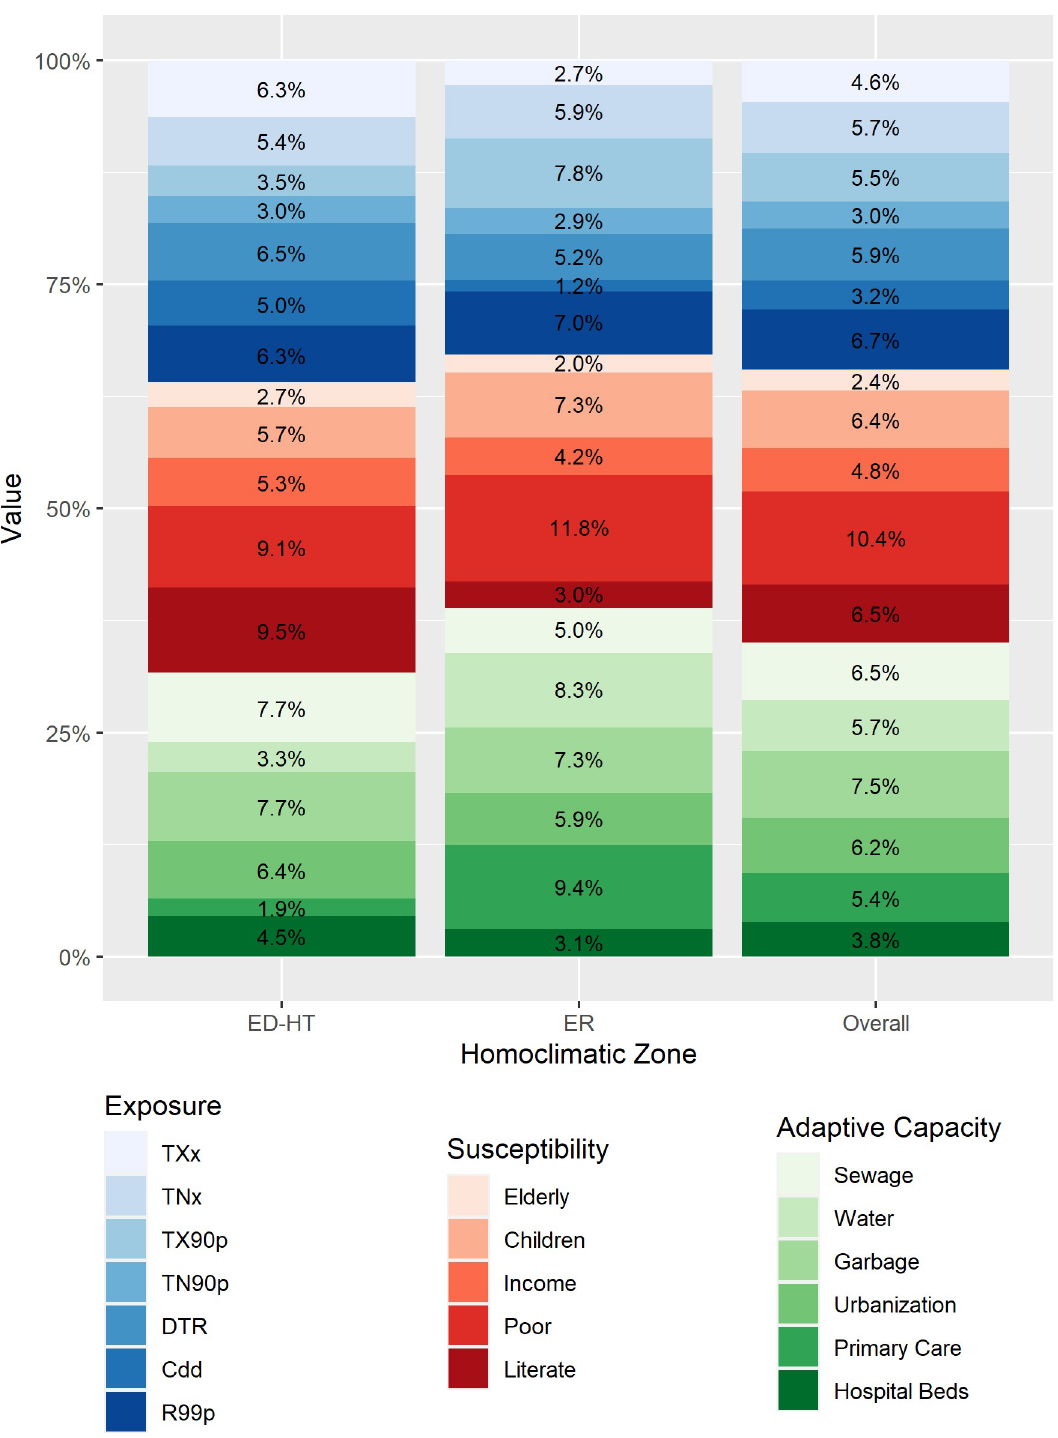
PLOS ONE | https://doi.org/10.1371/journal.pone.0259780 November11,